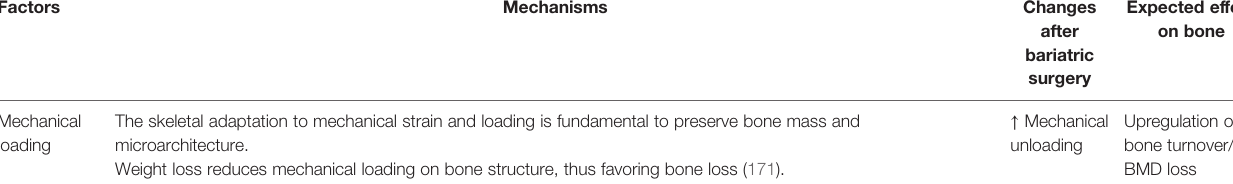
TABLE 3 | Summary of the mechanisms hypothesized to explain the negative effects of bariatric surgery on bone metabolism.